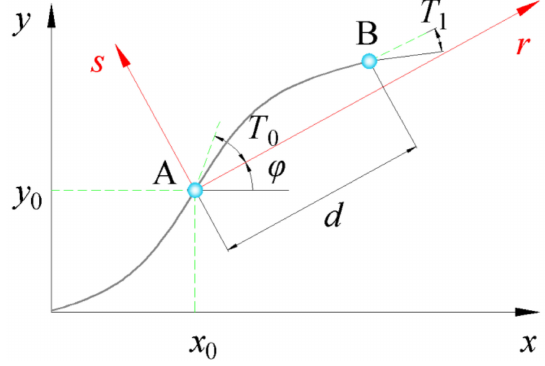
Figure 2. Fiber path with linear angle